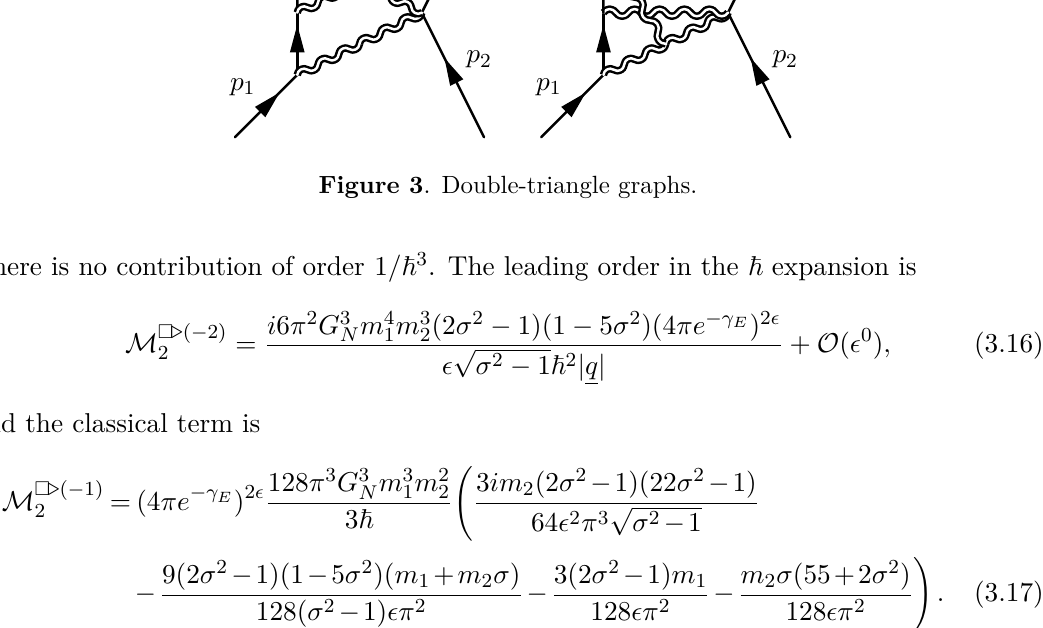
Figure 2 . Box-triangle graphs.